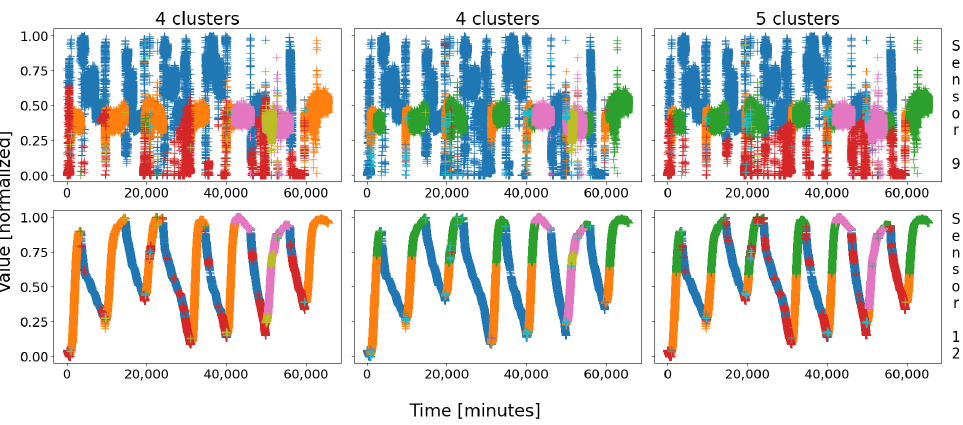
Figure 7. Battery 2 ( D 2 ) clustering comparison (3 × 3 SOM). The SOMs end up with three possible configurations, with four or five main clusters; these configurations are the columns, whilst the rows are two of the sensors of the database, sensor 9 ( top ) and sensor 12 ( bottom